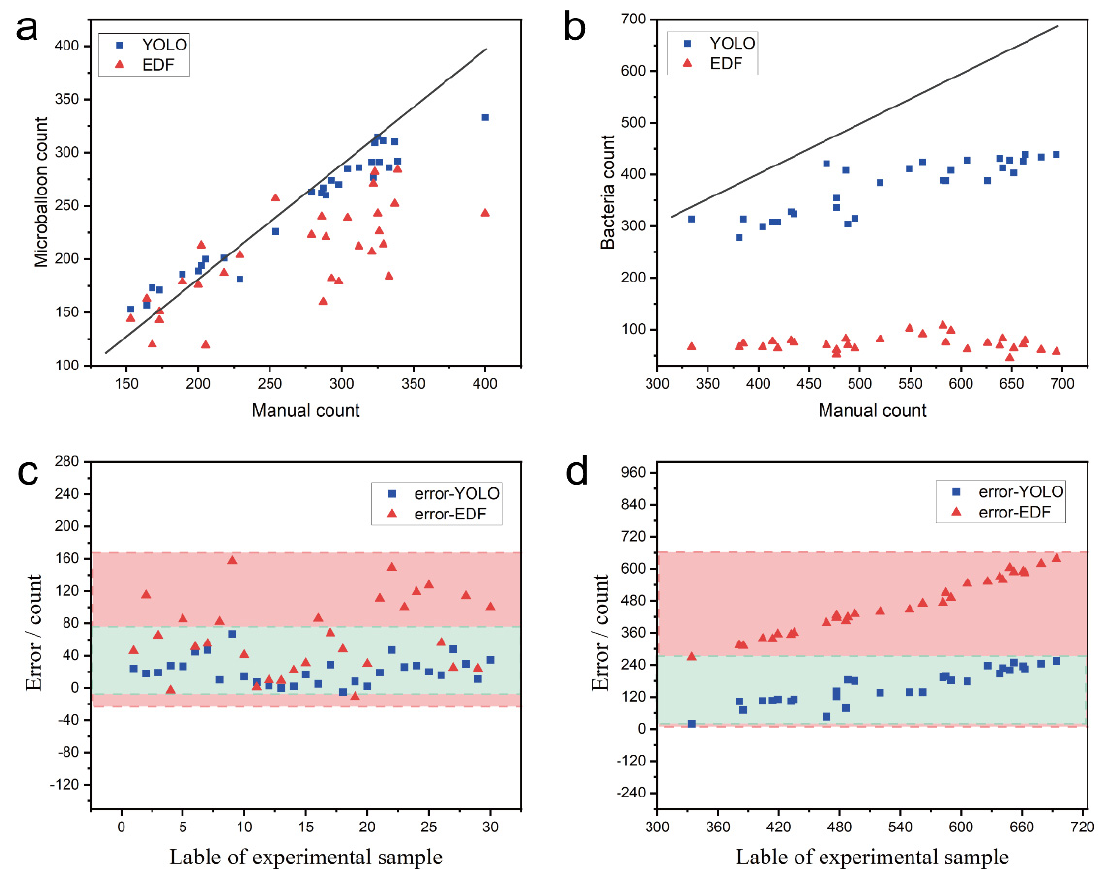
Figure 6. Comparison of microsphere and bacterial counting results between stacking and layer-by- layer scanning: ( a ) microballoon; ( b ) bacteria; and counting deviation comparison for microsphere and bacteria: ( c ) microsphere; ( d ) bacteria.